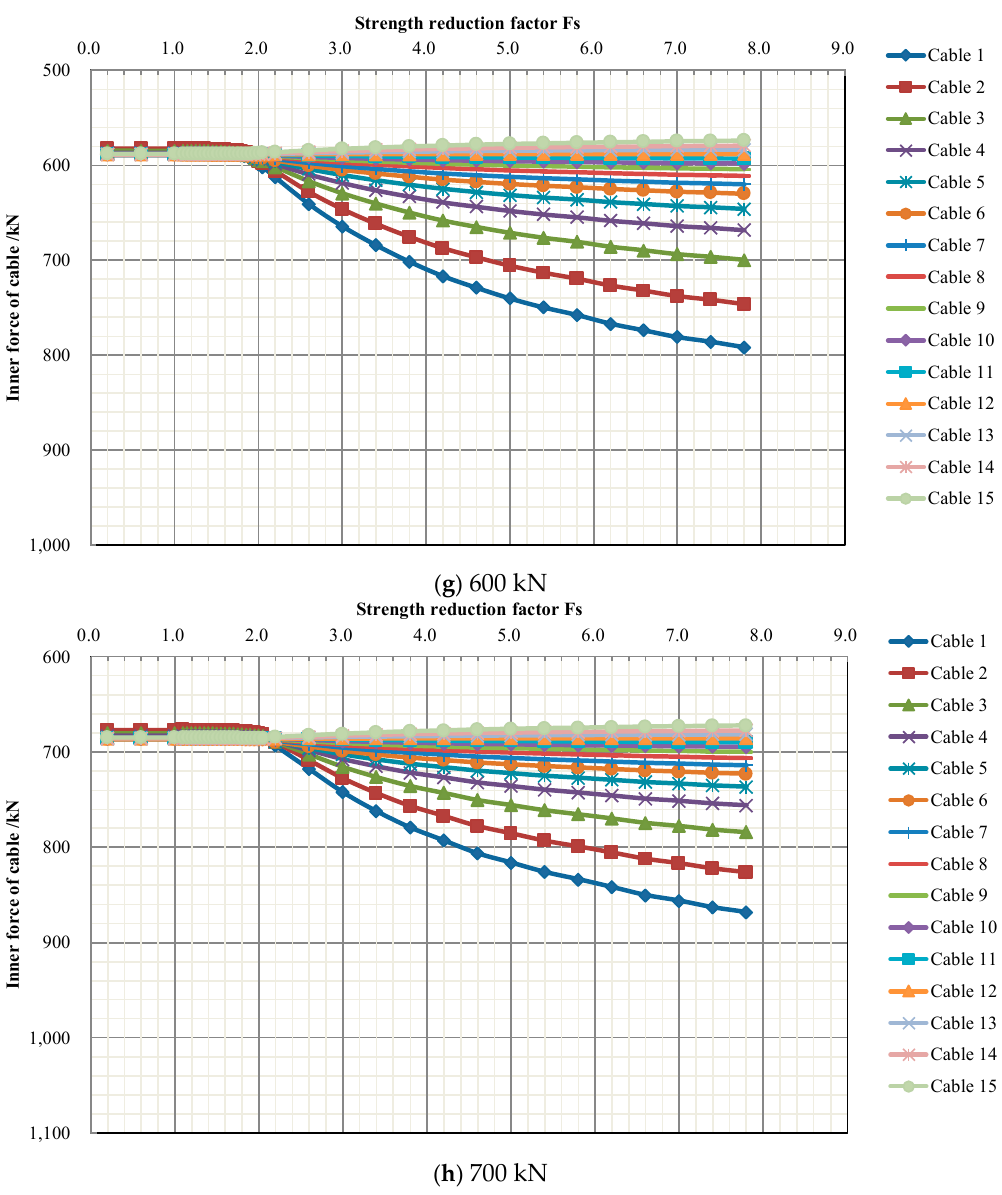
Figure 8. Variations of force with different strength reduction factors at a given cable prestress level.